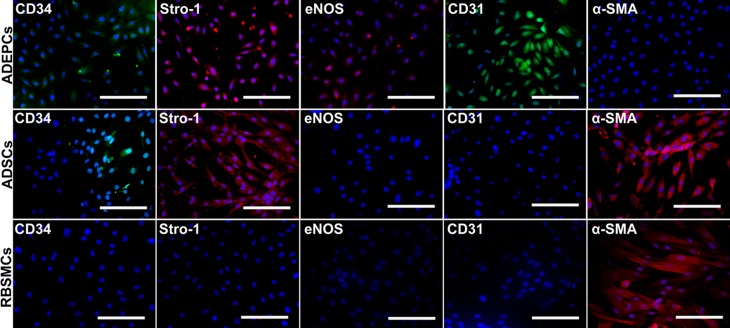
Immunofluorescence staining of ADEPCs, ADSCs and RBSMCs.ADEPCs were stained positively for CD34, Stro-1, eNOS and CD31 but negatively for α-SMA. ADSCs were stained positively for CD34, Stro-1 and α-SMA but negatively for eNOS and CD31. RBSMCs were only stained positively for α-SMA. Scale bar = 100 μm